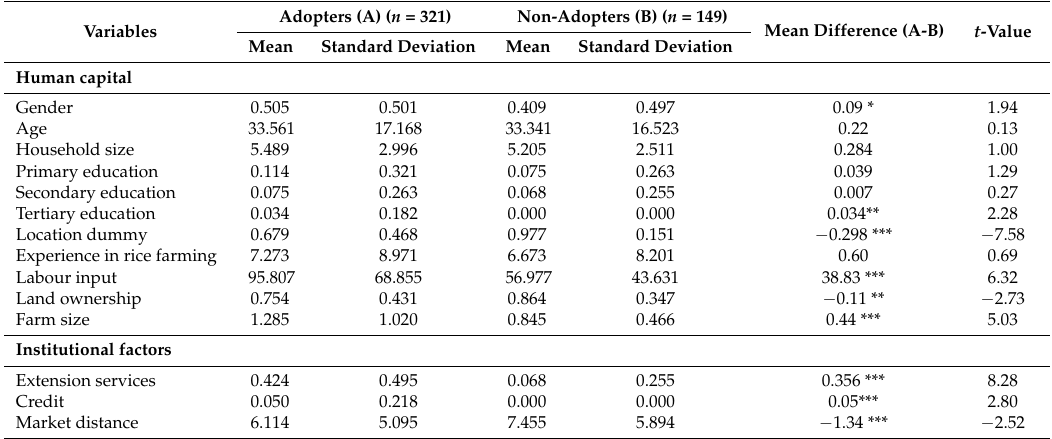
Table 2. Means and standard deviations of the explanatory variables included in the model.